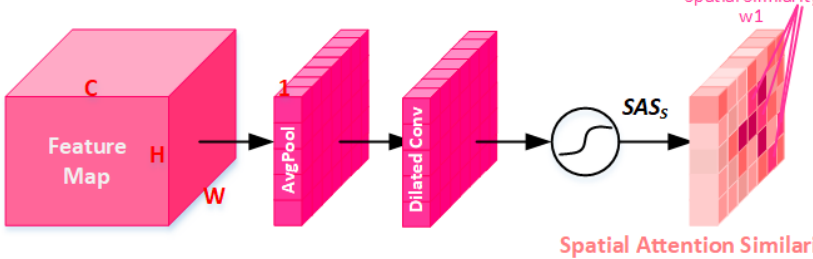
Figure 4. Spatial attention similarity module. Spatial similar regions have similar weights, and spatial key features have larger